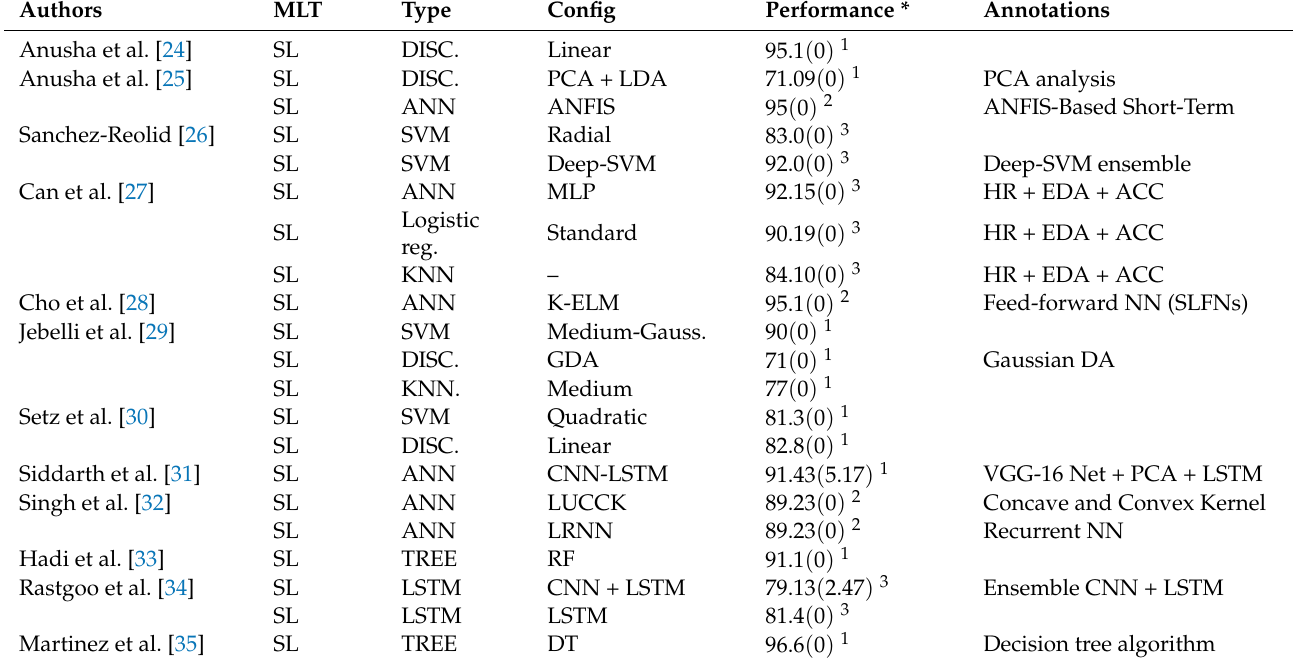
Table 12. Supervised learning methods for stress